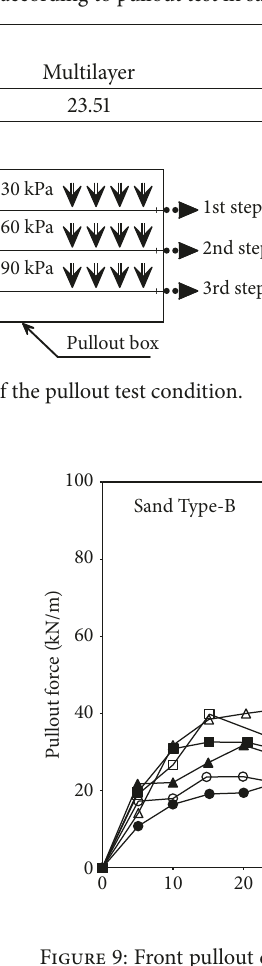
Table 6: Pullout parameters according to pullout test in sand.